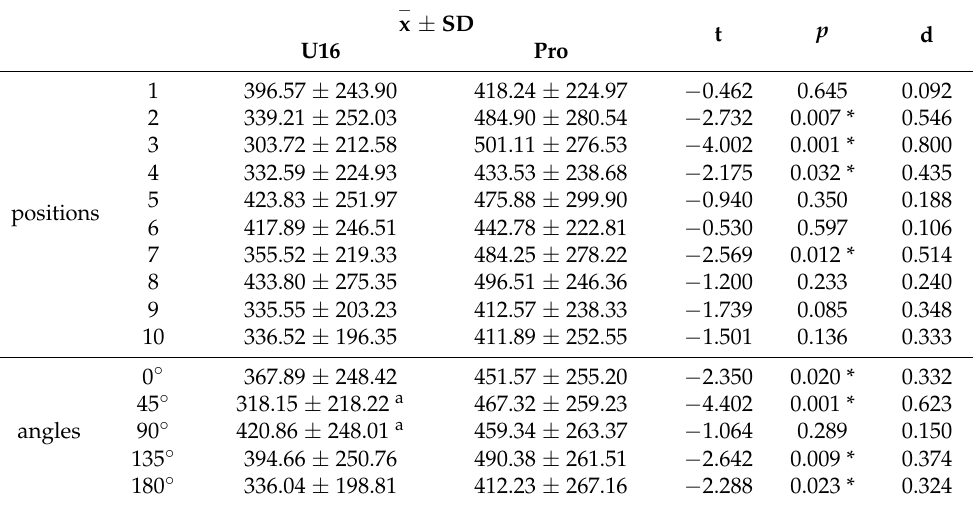
Table 6. Between-group comparison for last fixation duration, according to position and angle (times in